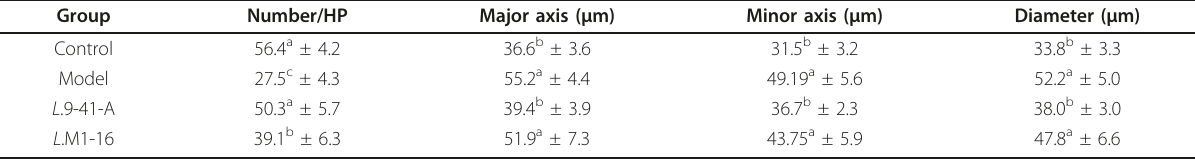
Table 4 Adipocyte number and size in the WAT under each field (n = 10 per group)